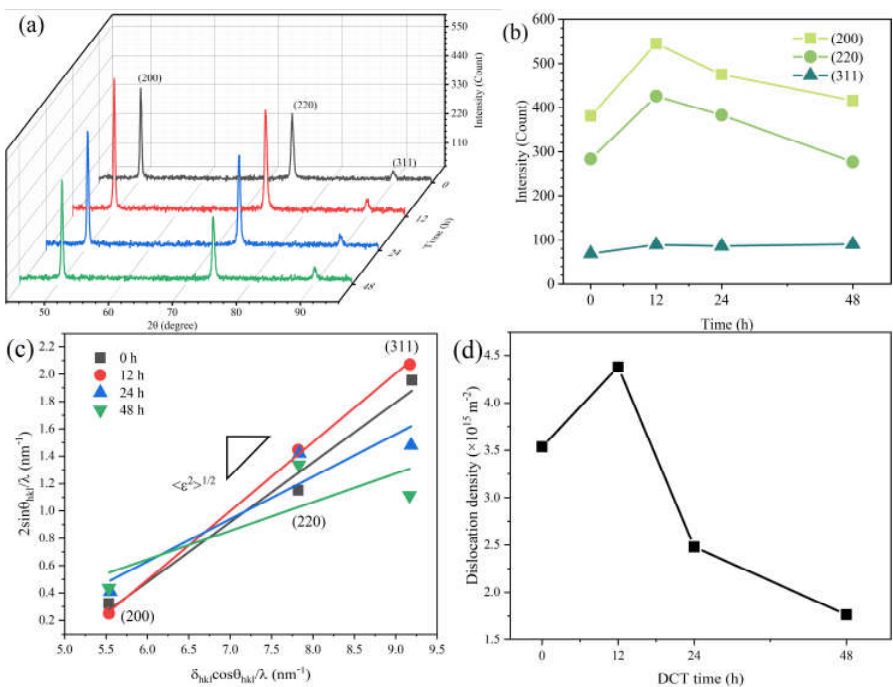
Figure 4. XRD patterns of Cu foil at various DCT times. ( a , b ) the intensities of different diffraction peaks, ( c ) the relationship between 2sinθ hkl /λ and δ hkl cosθ hkl /λ , and ( d ) the result of dislocation